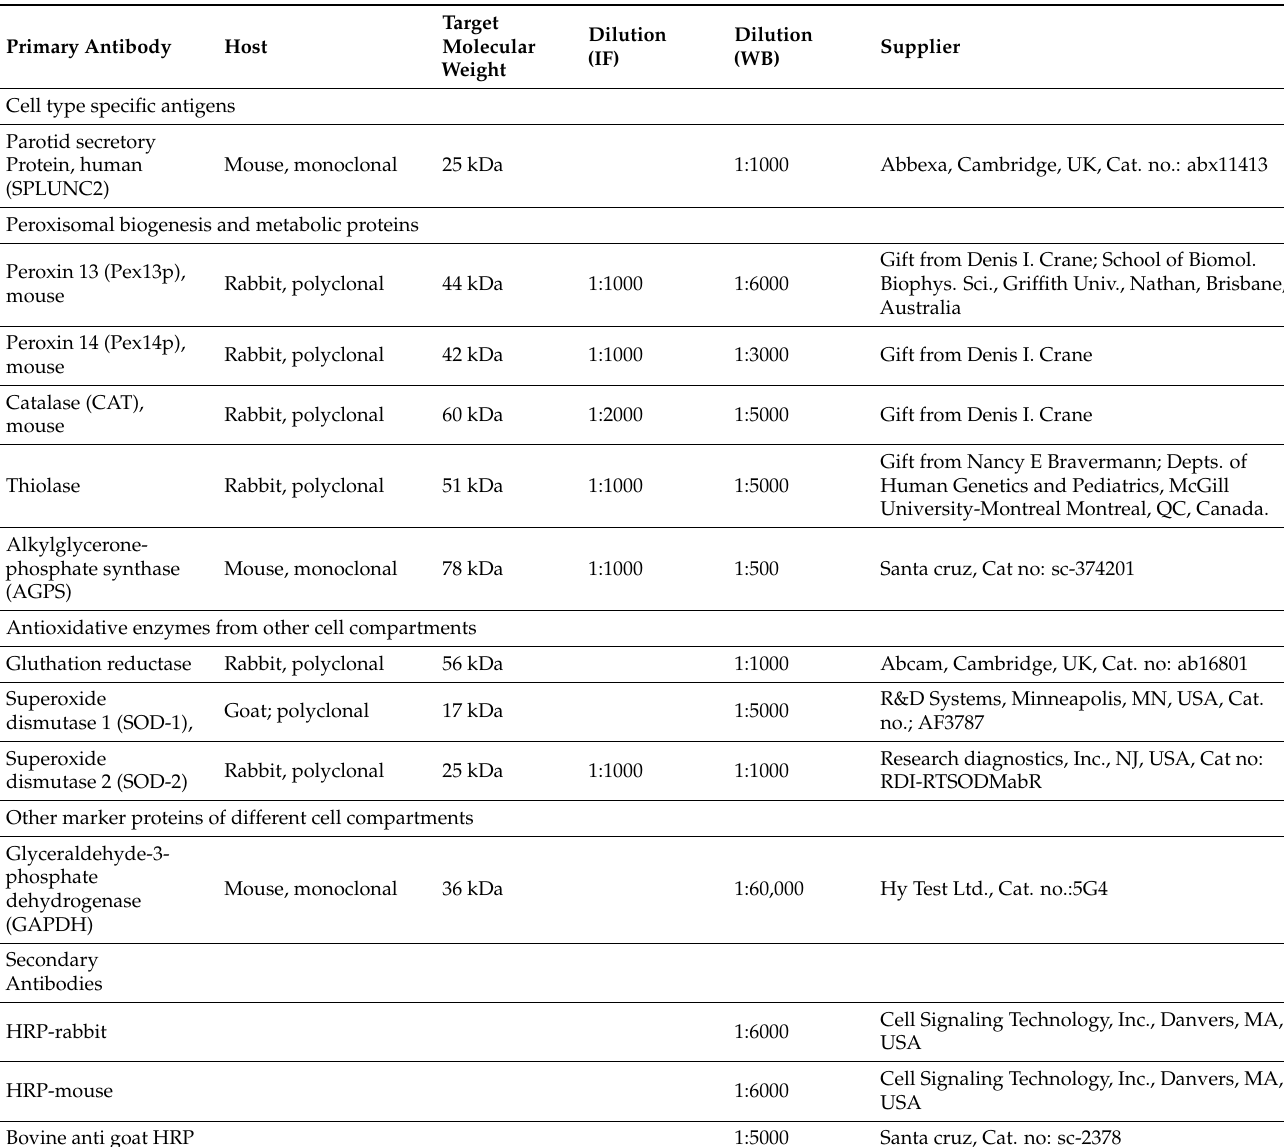
Table 1. List of antibodies used for the detection of peroxisomal proteins in the parotid